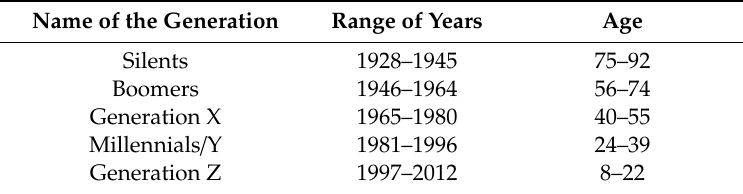
Table 1. The generation